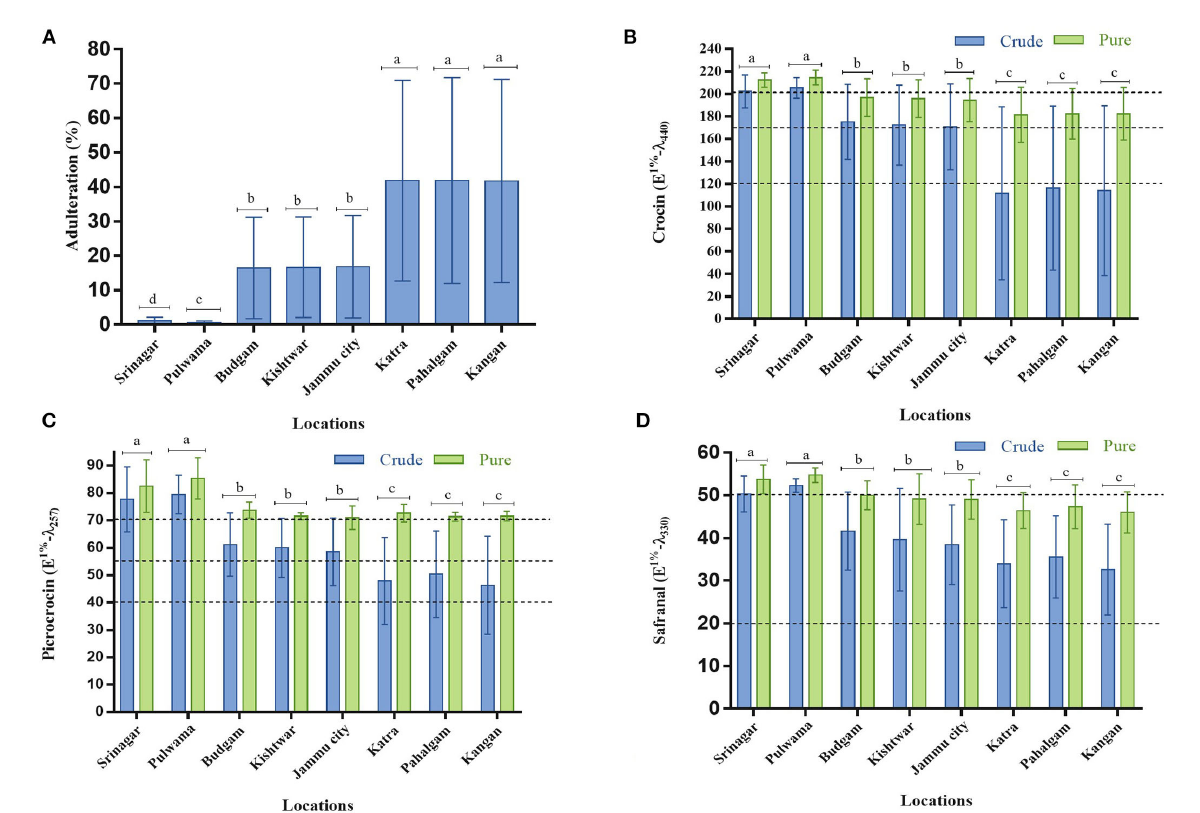
FIGURE7 Assessment of saffron quality obtained from different locations of Jammu and Kashmir (India) in pure and adulterated samples: (A) Adulteration percent, (B) crocin, (C) picrocrocin, and (D) safranal content. The dotted lines represent the maximum and minimum values of crocin, picrocrocin, and safranal for the categorization of saffron quality as per ISO 3632 standards. Values are the mean of 10 replicates and expressed as mean ± S.D (standard deviation). The letters a, b and c indicate a statistically significant difference at p ≤ 0.05 probability level between different locations. Bars with no common letters are significantly different ( p ≤